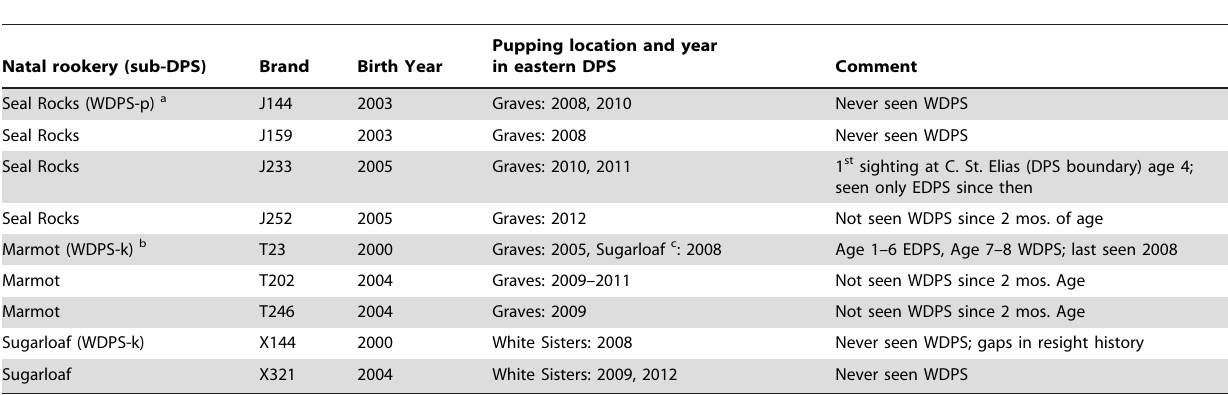
Table 7. Female Steller sea lions born in the western DPS that gave birth in the eastern DPS within Alaska, 2000–2012.